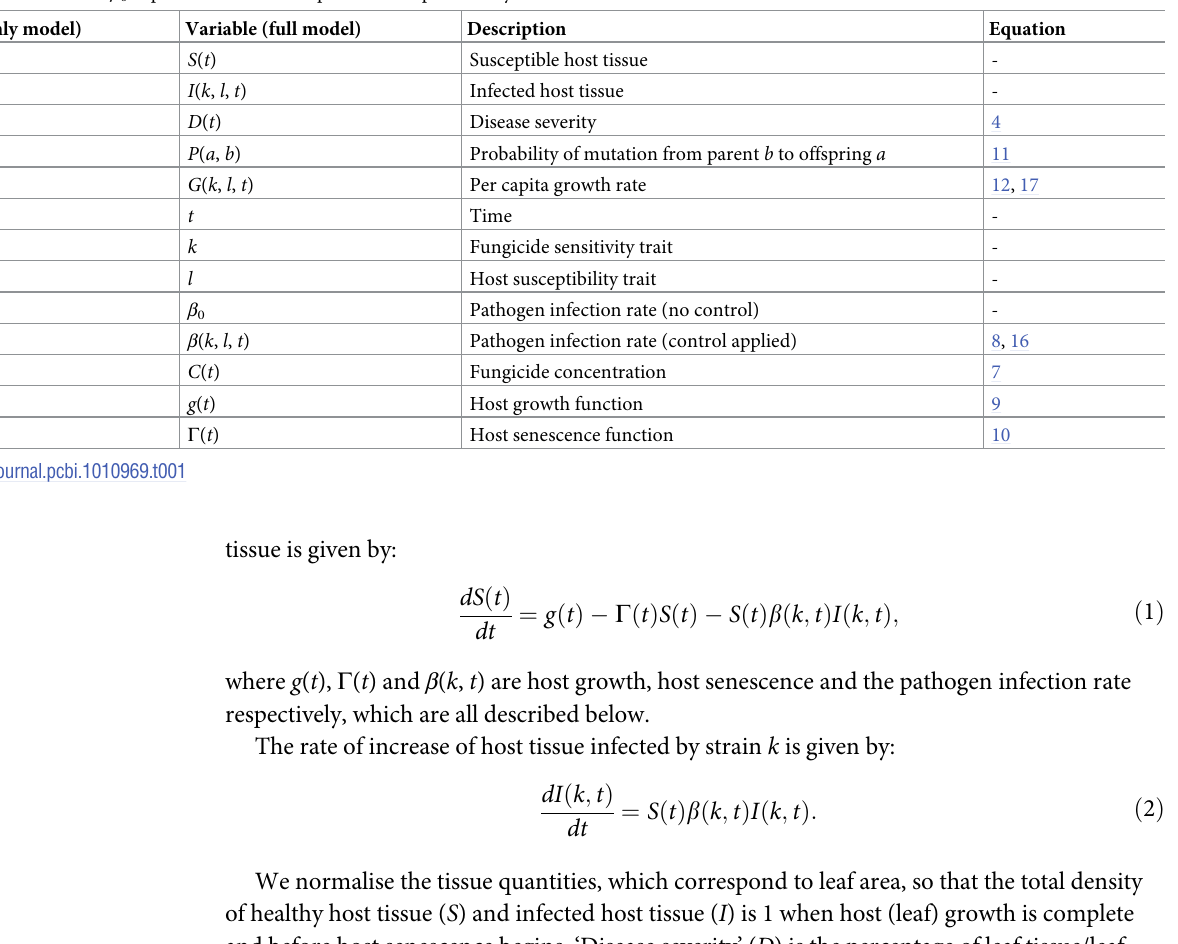
Table 1. List of variables used. Many of the variables vary with time t . Infection I also depends on trait values k , l . The pathogen infection rate β depends on k , l and t . The uncontrolled pathogen infection rate β 0 depends on the disease pressure in a particular